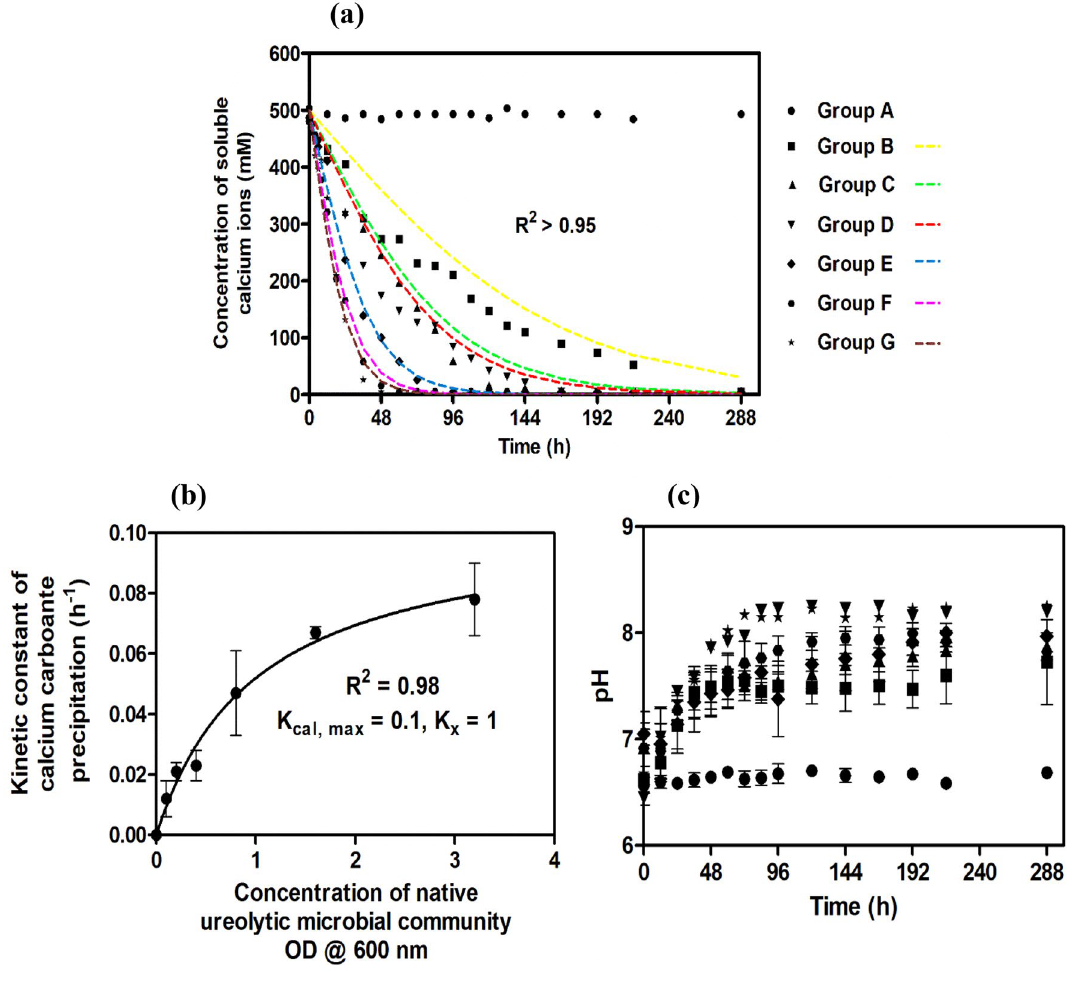
Figure 1. Concentration of soluble calcium ions over time (a) . The relationship between the kinetic constant of CaCO 3 precipitation and concentration of the native ureolytic microbial community (b) . The variation of pH with time (c) . Group A—0 OD NUMC, Group B—0.1 OD NUMC, Group C—0.2 OD NUMC, Group D—0.4 OD NUMC, Group E—0.8 OD NUMC, Group F—1.6 OD NUMC, and Group G—3.2 OD NUMC. NUMC Native Ureolytic Microbial Community. The coloured hidden lines are computationally fitted curves. Error bars in the figure indicate the standard deviation of three independent trials.